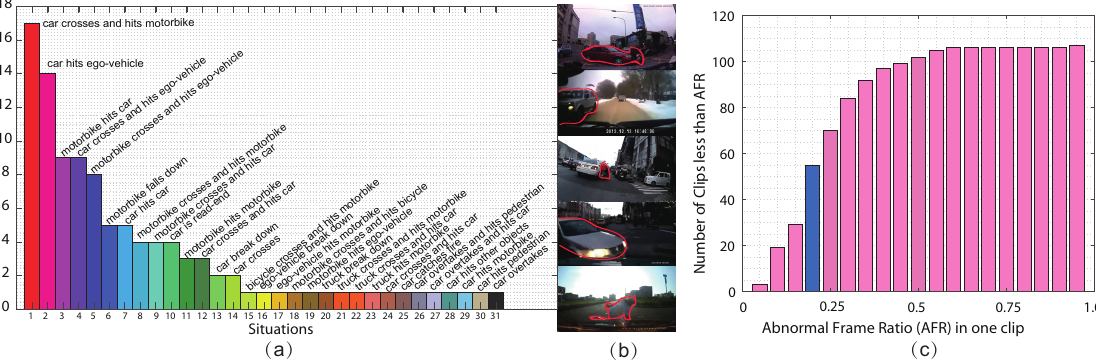
Figure 5. The statistics of Drive-Anomaly106. ( a ) the situation distribution; ( b ) the typical frames in the top five kinds of situations, where the anomaly regions are marked by red contour; ( c ) the abnormal frame ratio of the clips in